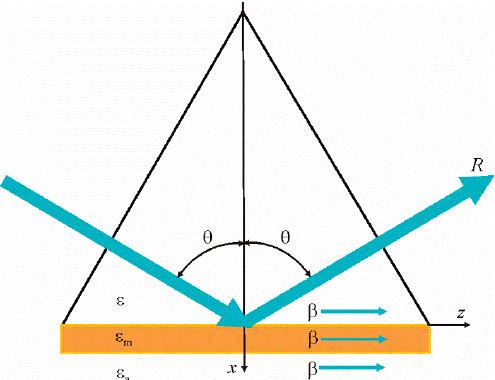
Figure 1. The optical scheme of the prism structure, β is propagation the constant of the surface plasmon polariton wave, ε is the dielectric constant of the prism material, ε m is the dielectric constant of the metal, and ε a is the dielectric constant of the researched medium.